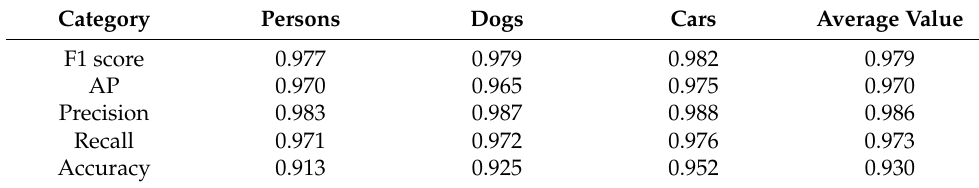
Table 4. Model evaluation indicators of salient object